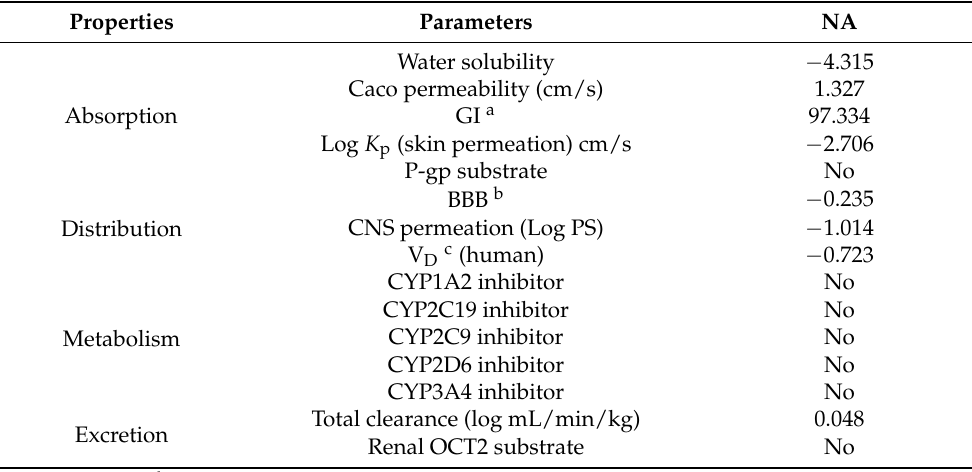
Table 2. Predicted ADME parameters of NA.